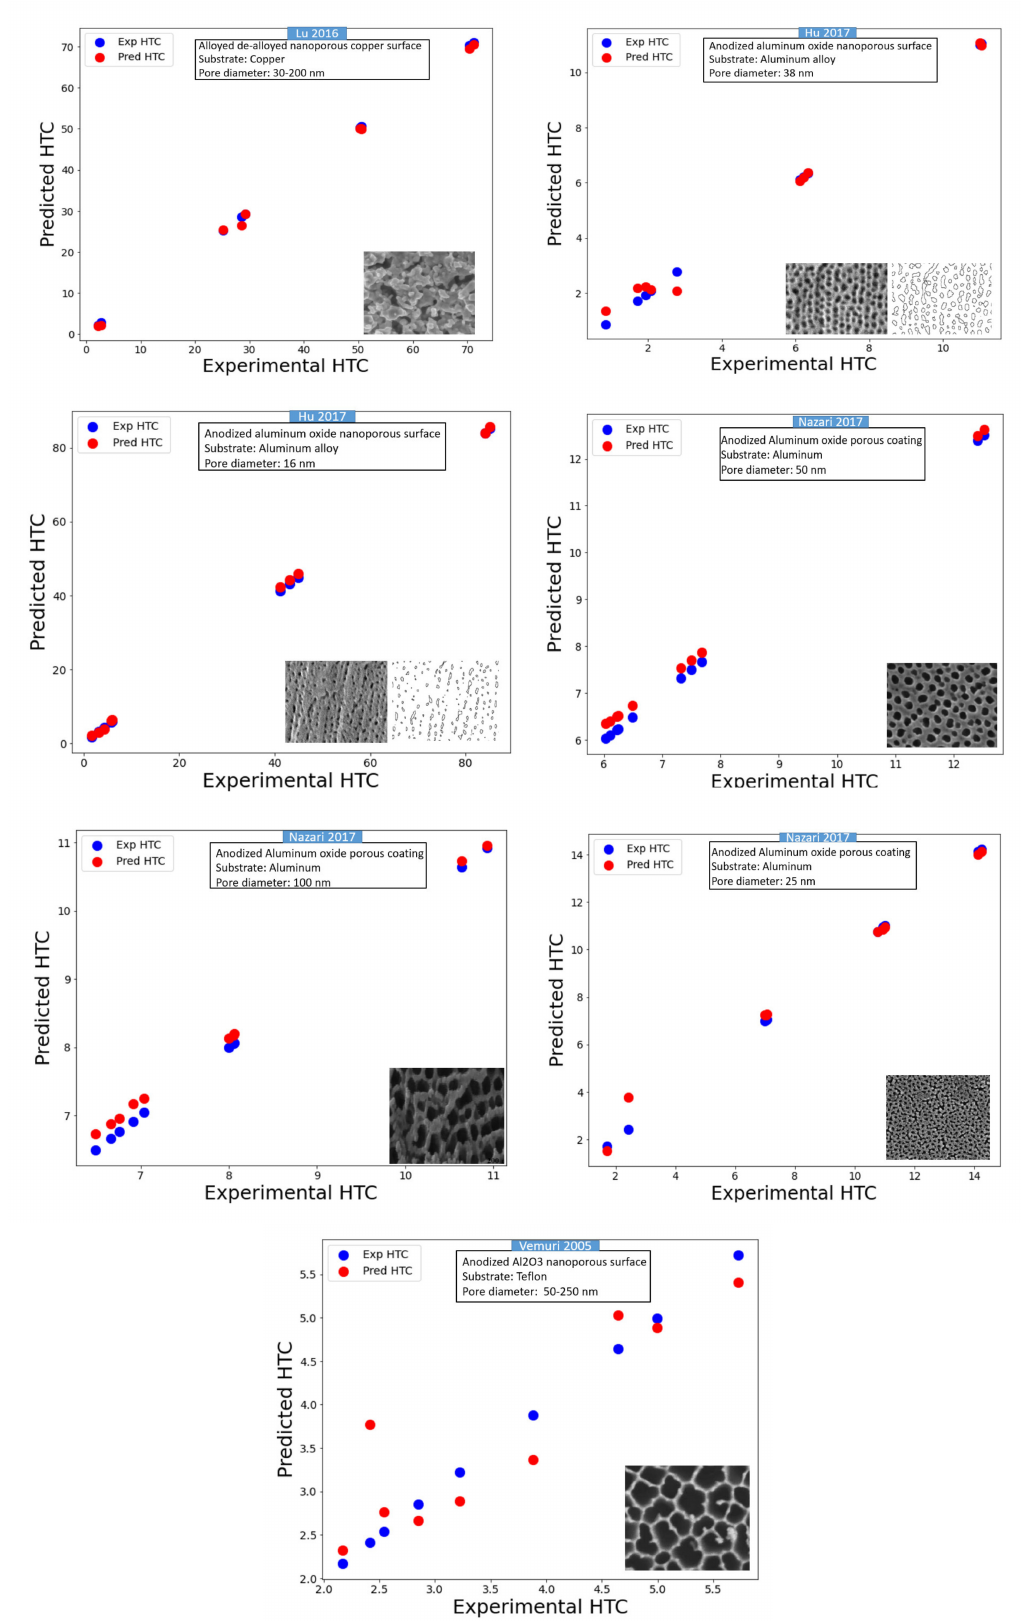
Figure 10. Assessment of various nanoporous coated surfaces available in the literature (note that HTC was taken in kW/m 2